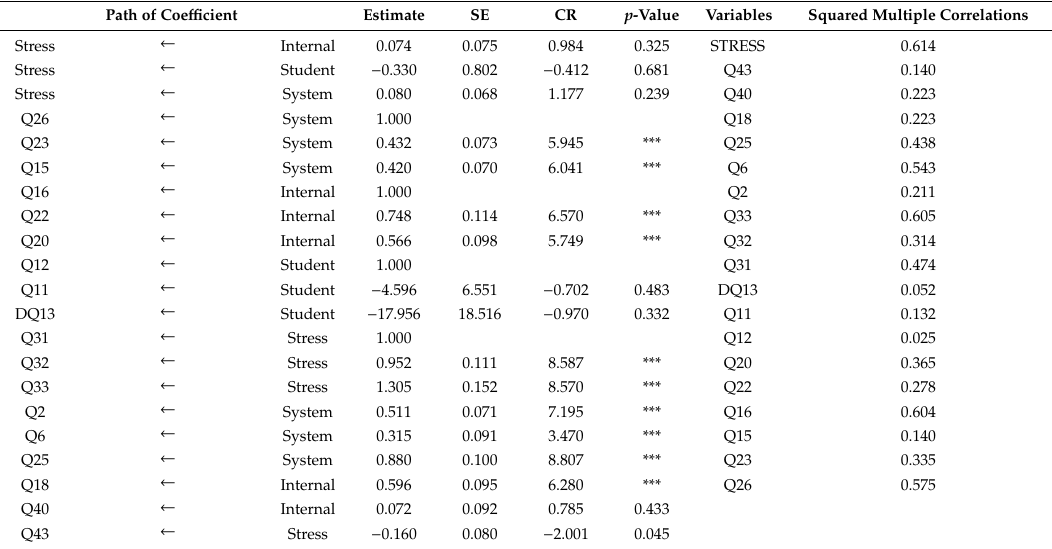
Table 11. Testing of the causal model of STRESS.